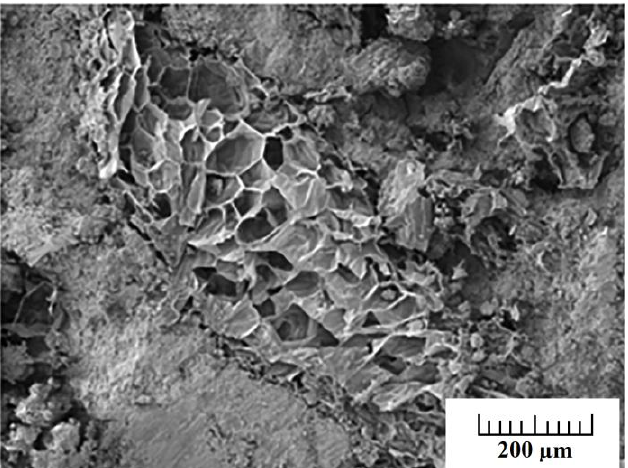
Figure 21. Scanning electron microscopy (SEM) images of mortar produced with EPS aggregate. Reprinted with permission from ref. [63].